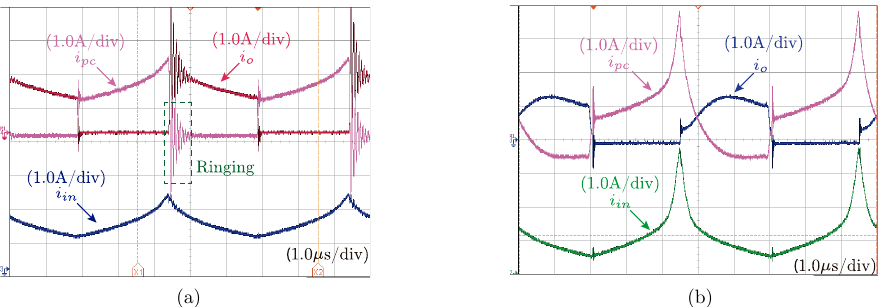
Figure 5. Current measurements in the proposed converter. ( a ) Without the clamping circuit and D = 0.48. ( b ) With the clamping circuit and D =